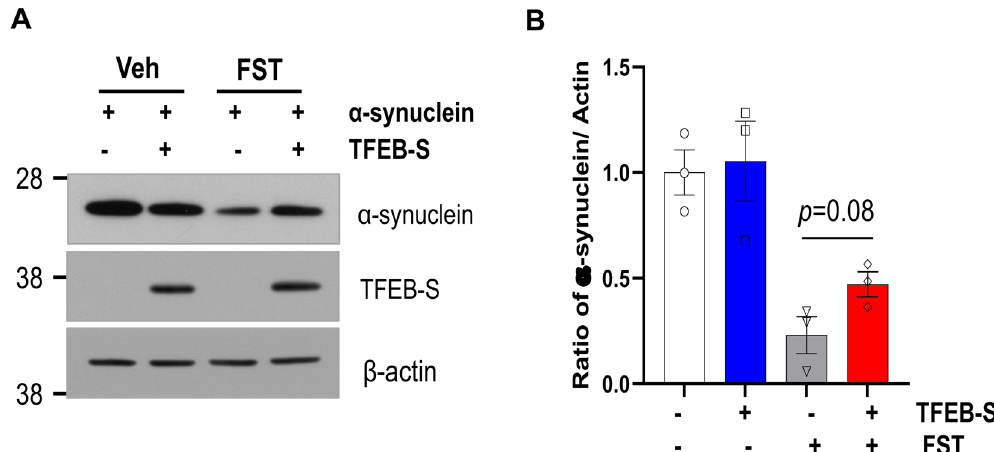
Figure 8. Small TFEB ameliorates fisetin-induced clearance of α-synuclein. HEK293 cells were transiently co-transfected with the plasmid expressing α-synuclein and either the plasmid expressing small TFEB or an empty vector. The cells were treated with 10 μM fisetin for 12 h. ( A ) The protein levels of α-synuclein, small TFEB (TFEB-S), and actin were analyzed by immunoblotting using anti-Myc, anti-HA and anti-actin antibodies, respectively. Full blots are provided in Supplementary Fig. S6. ( B ) Bar graph represents the relative ratio of α-synuclein normalized with that of actin. The data are shown as the mean ± S.E. of three independent experiments and were analyzed using Student’s t